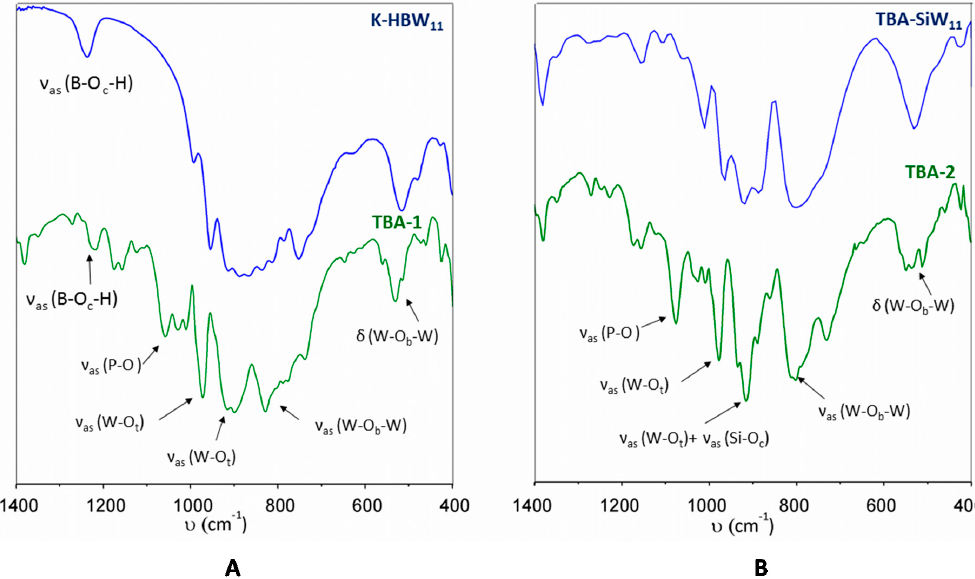
Figure 1. FT-IR spectra of TBA-1 ( A ) and TBA-2 ( B ) compared with those of their corresponding precursors K 8 [HBW 11 O 39 ]·13H 2 O and TBA 8 [SiW 11 O 39 ].